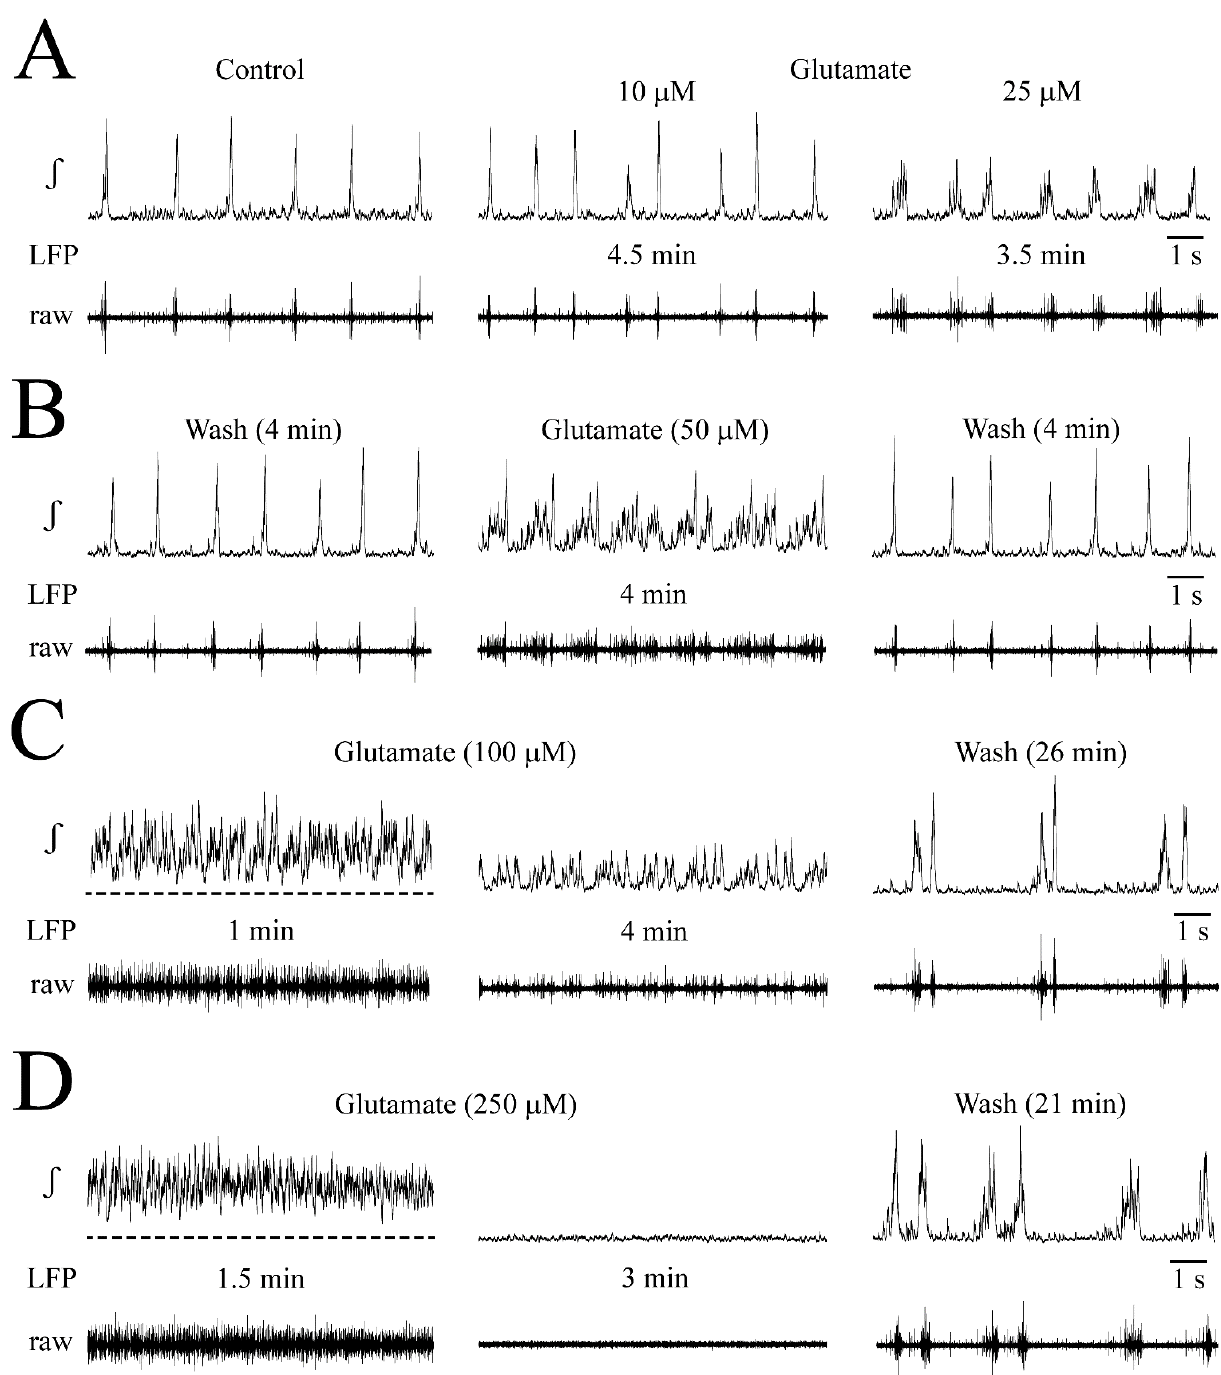
Figure 5. Glutamate effects on LFP pattern. Recording is from a single slice. ( A ) A dose of 10 μ M glutamate had no effect, whereas 25 μ M changed the LFP pattern to longer-lasting, smaller amplitude events. ( B ) After wash, 50 μ M evoked almost merged, crescendo-shaped multipeak events. ( C ) After wash, 100 μ M at 1 min raised integrated trace baseline as an indication of tonic activity evident on raw trace, but still showed groups of multipeak events before rhythm stopped at 4 min. Recovery resulted in same number of events as in control, but they appeared now as doublets. ( D ) 250 μ M caused initially massive tonic activity before rhythm ceased at 3 min. Recovery after 21 min re-established rhythm at a rate similar to control. This time, LFP doublets were intermingled with single events and all had crescendo-like shapes similar to those in 25 and 50 μ M glutamate.